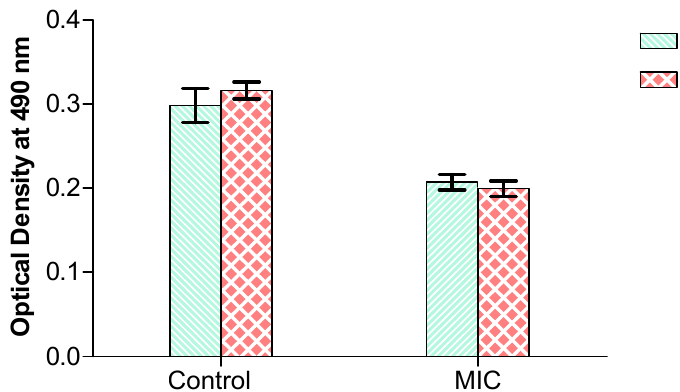
Figure 2. The effect of the extract on respiratory chain dehydrogenase.